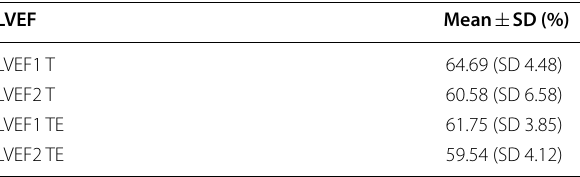
Table 5 LVEF values measured before and after both antibody drug protocols